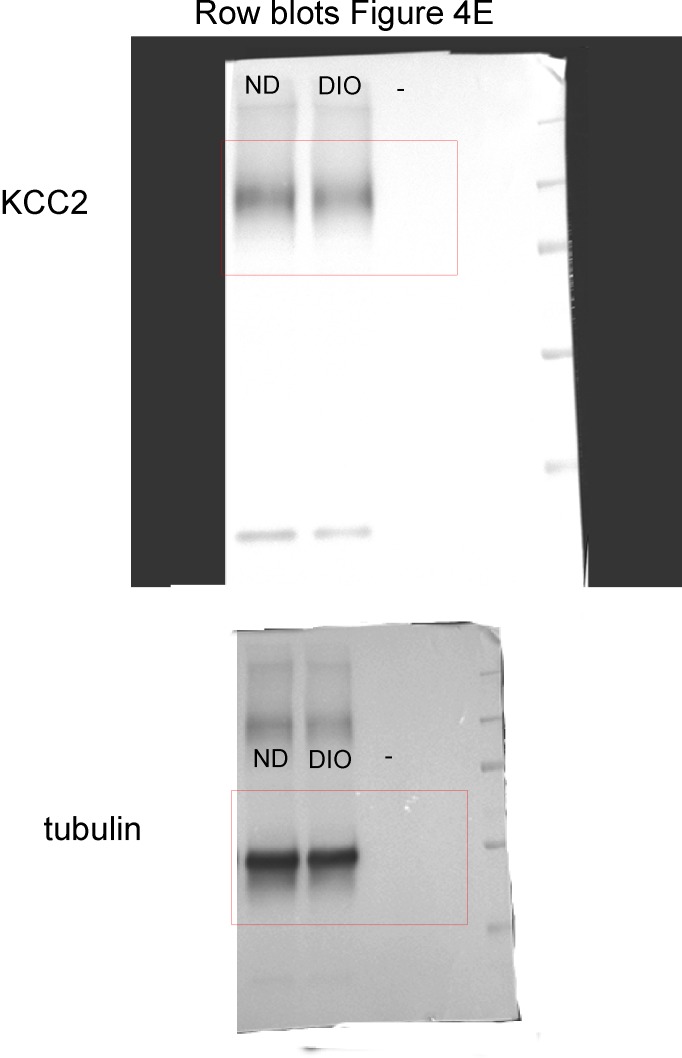
Raw blots for panel E (ND and DIO).